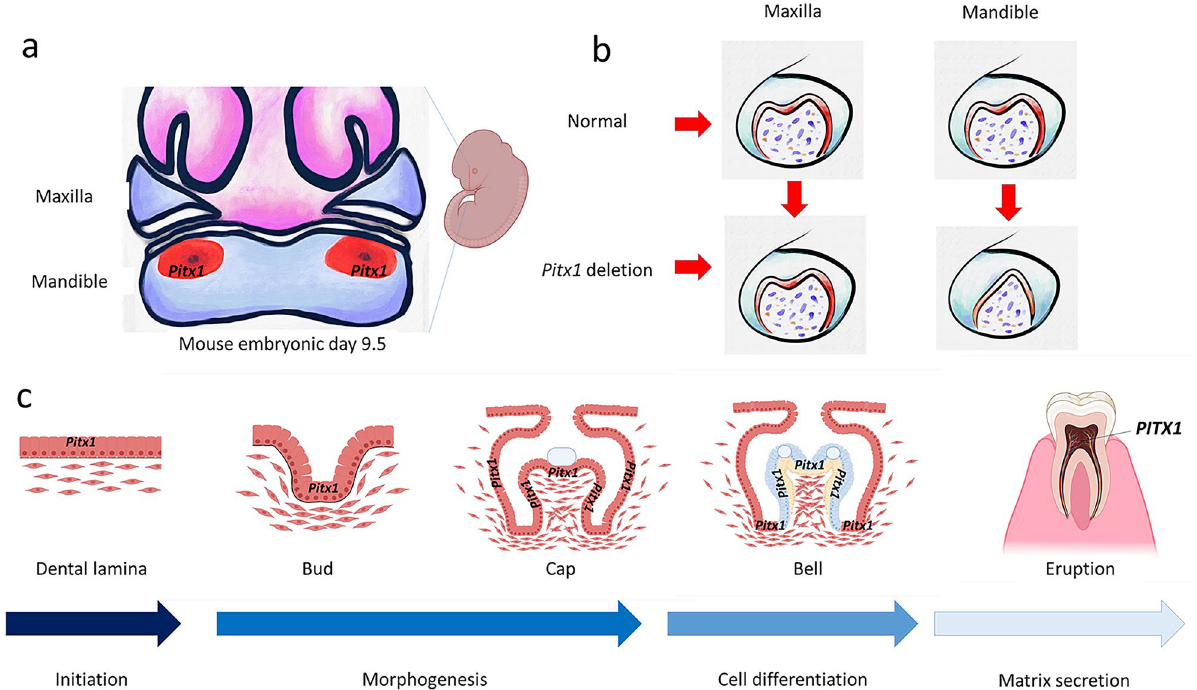
Figure 6. PITX1 expression in the teeth. ( a ) Pitx1 in mouse embryo is expressed in the mandibular mesenchyme where molars develop. ( b ) A picture demonstrates normal morphology of developmental maxillary and mandibular first molar of mouse embryo and the abnormal tooth development of the mandibular first molar (a presence of one cusp) in mouse embryo with Pitx1 gene deletion. ( c ) Schematic diagrams showing the stages of normal tooth development and PITX1